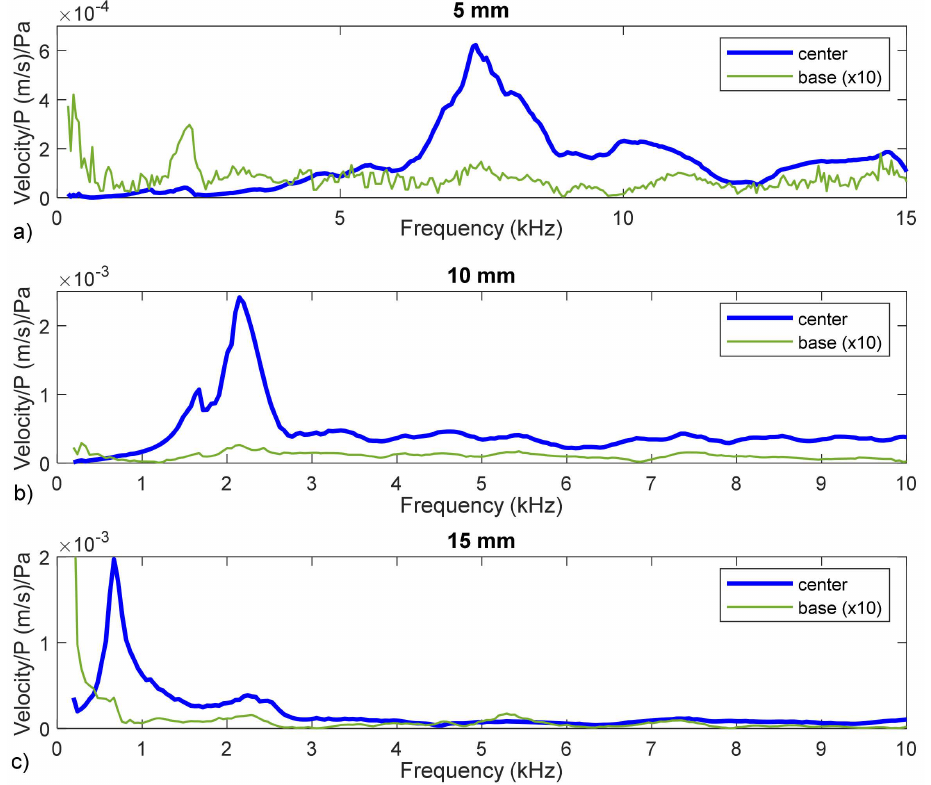
Figure 10. Membrane velocity transfer function. Responses of membranes with diameters of 5 mm ( a ), 10 mm ( b ), and 15 mm ( c ) for the center location (blue curve) and edge location (green curve). Responses at the edge location are scaled up to 10